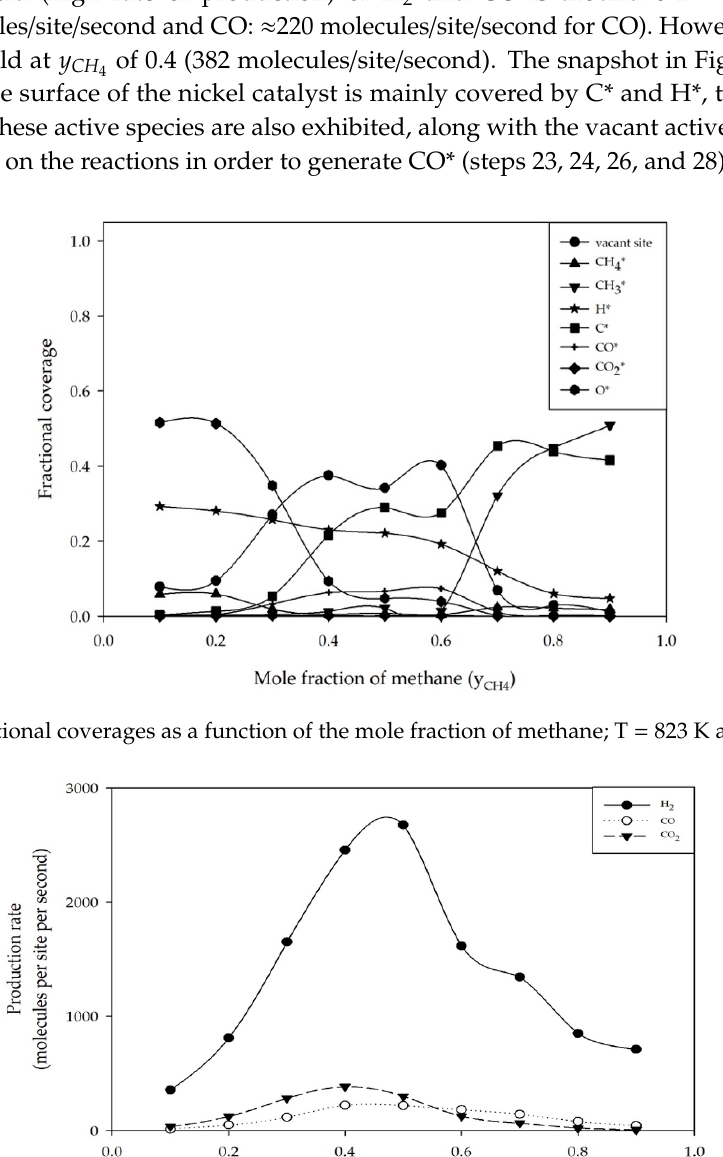
( c ) Figure 5. Snapshots of the surface of the nickel catalyst: ( a ) 𝑦 (cid:3004)(cid:3009) (cid:3120) = 0.2; ( b ) 𝑦 (cid:3004)(cid:3009) (cid:3120) = 0.5; ( c ) 𝑦 (cid:3004)(cid:3009) (cid:3120) = 0.7; T = 823 K, P = 1 bar ( □ = Empty, ■ = H*, ■ = C*, ■ = O*, ■ = CH 4 *, ■ = CH 3 *, ■ = CH 2 *, ■ = CH*, ■ = CO 2 *, ■ = CO*, ■ = OH*, ■ = H 2 O*, ■ = H 2 *, ■ = COOH*). 2.2. Effect of Reaction Temperature To observe the effect of the reaction temperature, the fractional coverages and production rates are investigated by varying the reaction temperature from 600 to 1123 K. The results are plotted as shown in Figure 6. When CH 4 adsorbs as CH 4 * on the nickel surface, it dissociates to CH 3 * and CH 2 * intermediates. The CH 4 * and CH 3 * coverages on the surface are high at 600 K, and as the temperature increases, both the CH 4 * and CH 3 * on the surface decrease. For O*, a similar trend of surface concentration is also observed. As the reaction temperature increases from 600 to 700 K, the surface coverages of C* and H* increase and then decrease after 700 K. Figure 6. Fractional coverages as a function of te reaction temperature; P = 1 bar and 𝑦 (cid:3004)(cid:3009) (cid:3120) = 0.4.